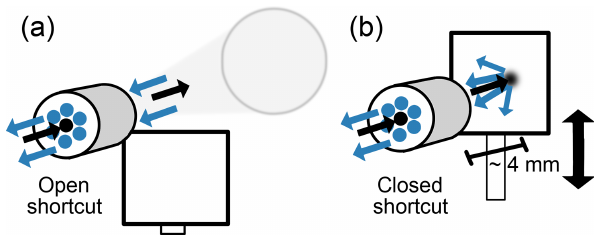
Figure A1. Working principle of the shortcut system. When the shortcut is open, light can reach the main mirror, traverse the at- mospheric light path, and be collected by the fibres (a) . To record a reference spectrum, a diffuse reflector plate (here a sandblasted aluminium plate) is moved into the light path at a distance of 1 to 4mm from the fibre end (b) . The radiation is scattered from the sur- face of this plate back into the fibre bundle without traversing the atmosphere and is thus free of atmospheric absorption.